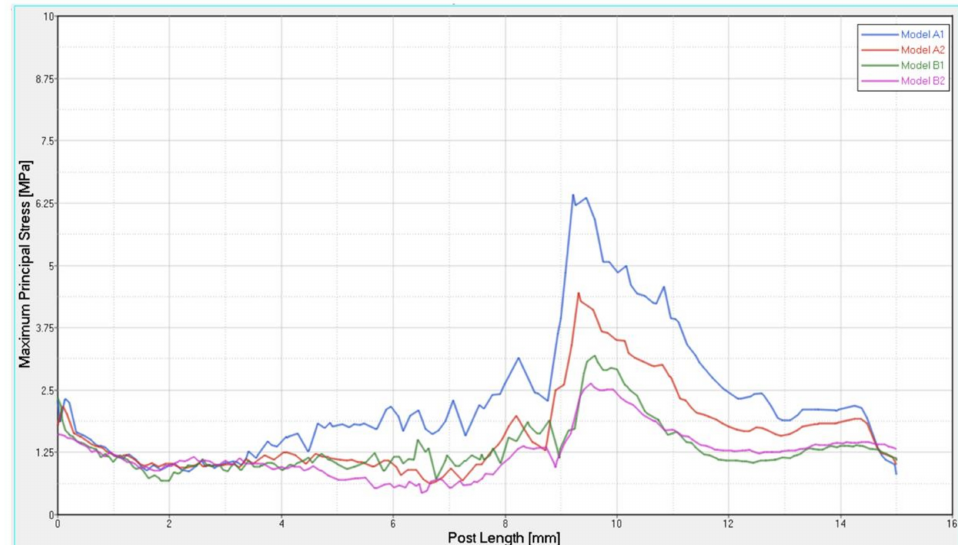
Figure 7. Models A1, A2, B1, and B2: Maximum principal stress distribution along the center of the post from the coronal to the apical part.